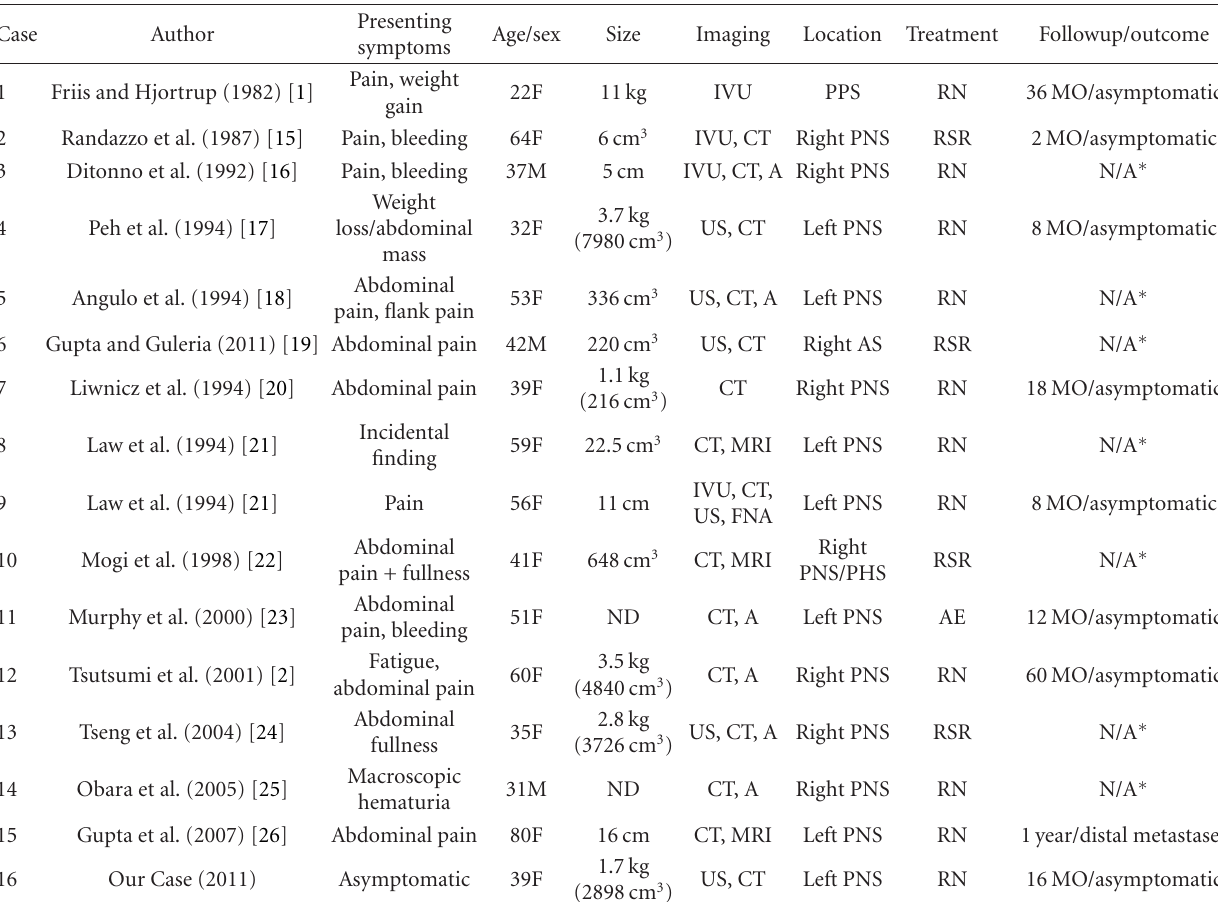
Table 2: Detailed information on all published retroperitoneal extrarenal angiomyolipomas